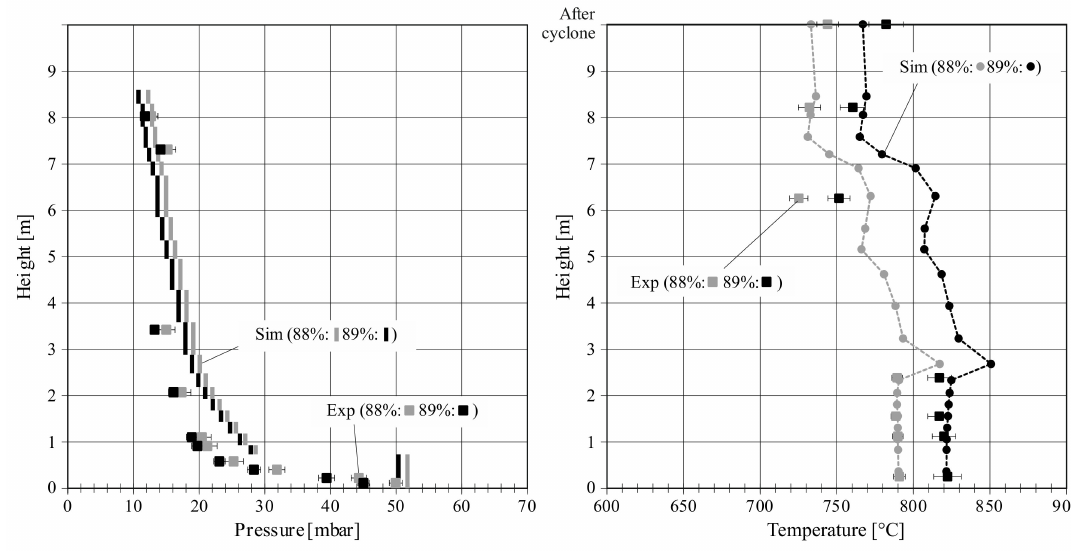
Figure 8. Pressure and temperature along the reactor at medium